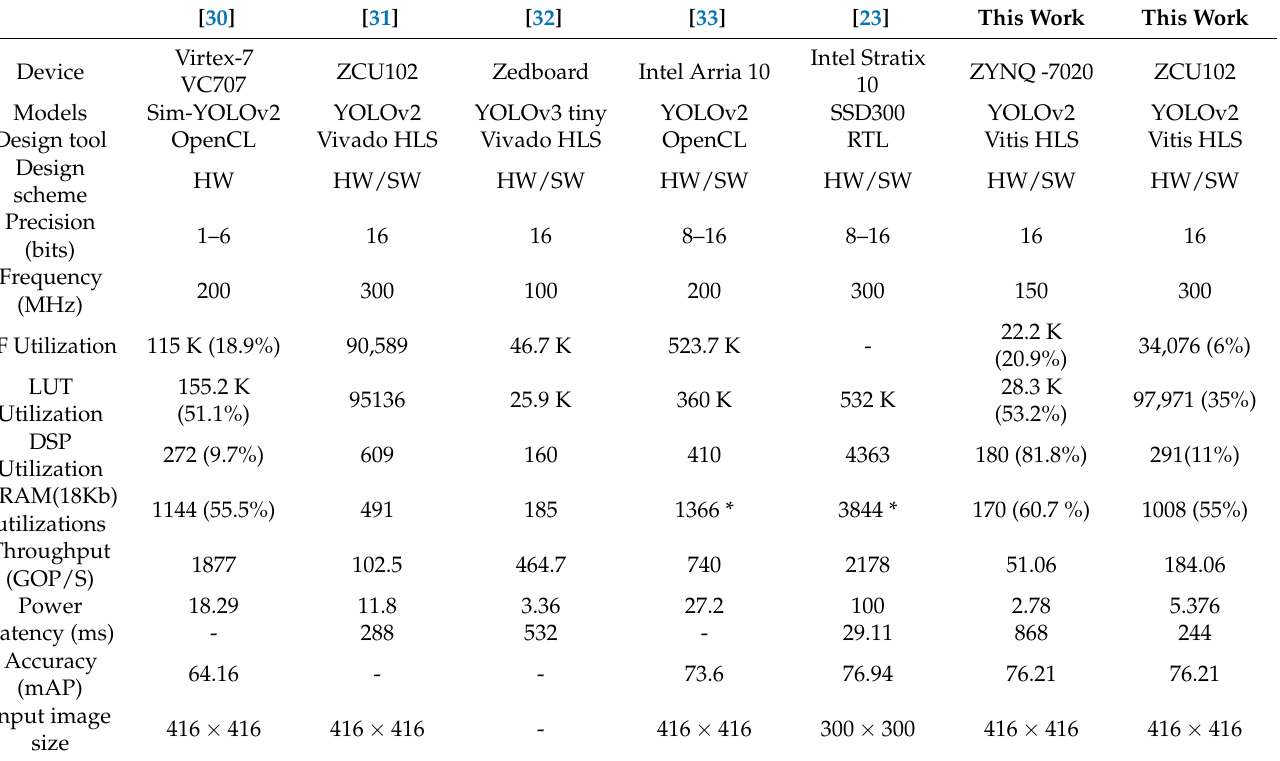
Table 5. Comparison of our implementation against other prior works using several